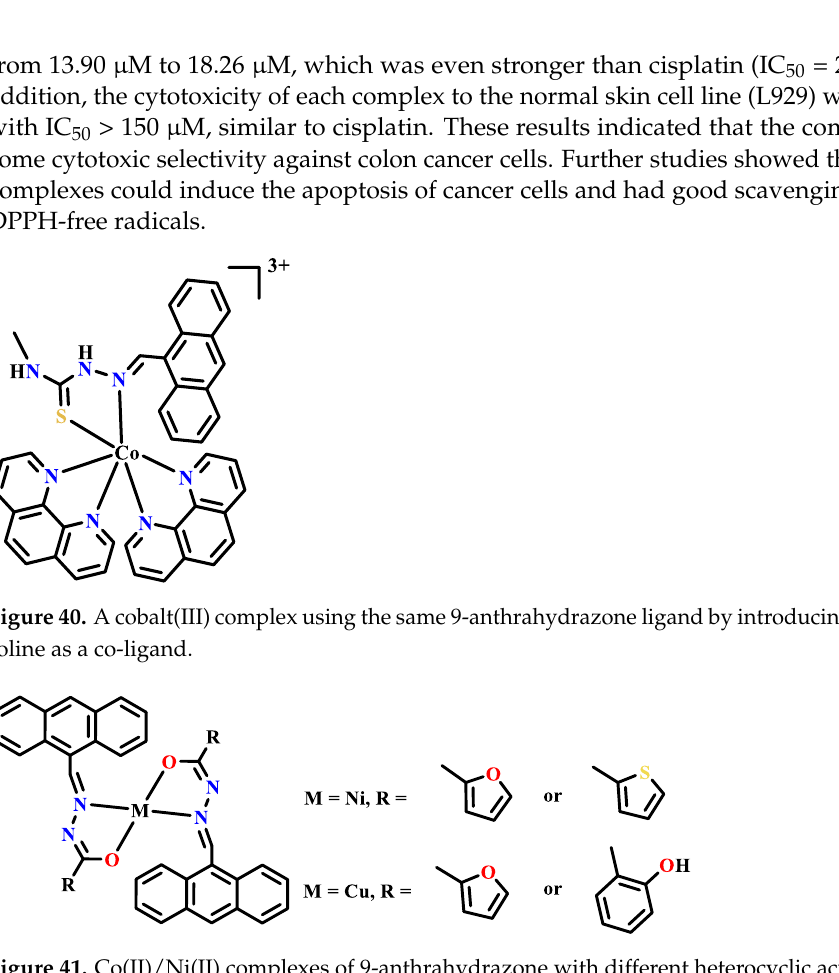
Figure 41. Co(II)/Ni(II) complexes of 9-anthrahydrazone with different heterocyclic acylamides as a side chain.